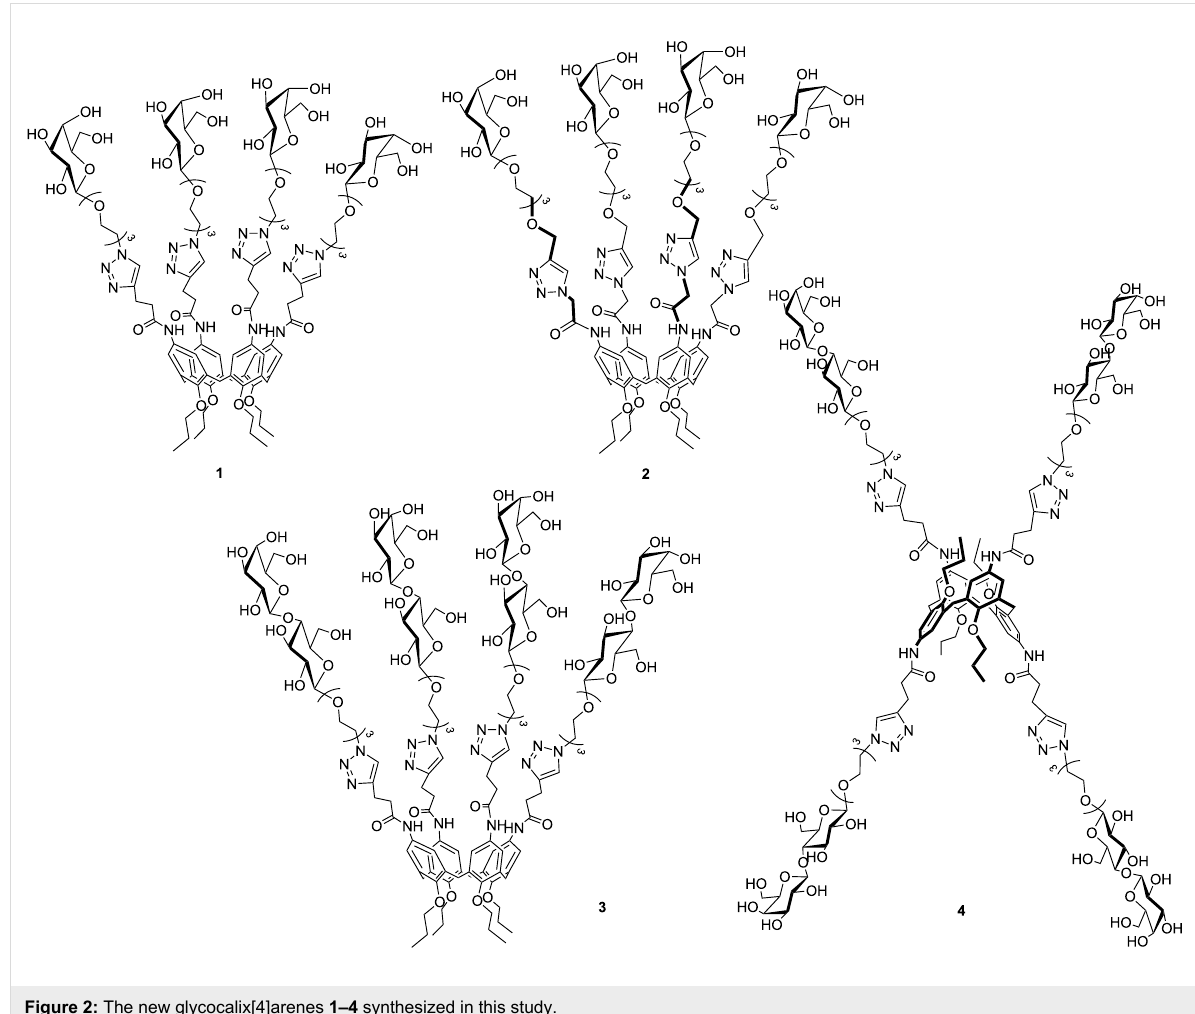
sugar by using a galactose and cone calixarene scaffolds. This investigation was carried out with the idea to extend the study to stronger ligating units for galectins such as lactose and different calixarene structures, also including the 1,3-alternate isomer. The first route explored (dipolarophile-on-the-calix) was applied to the preparation of the multivalent compound 1 , which could be synthesized by exploiting a convergent syn- thetic approach. This approach was based on the connection, by CuAAC reaction, of the azido-terminating tetraacetylgalactose 5 [40,41] to calix[4]arene 8 decorated at the upper rim with alkyne terminating chains (Scheme